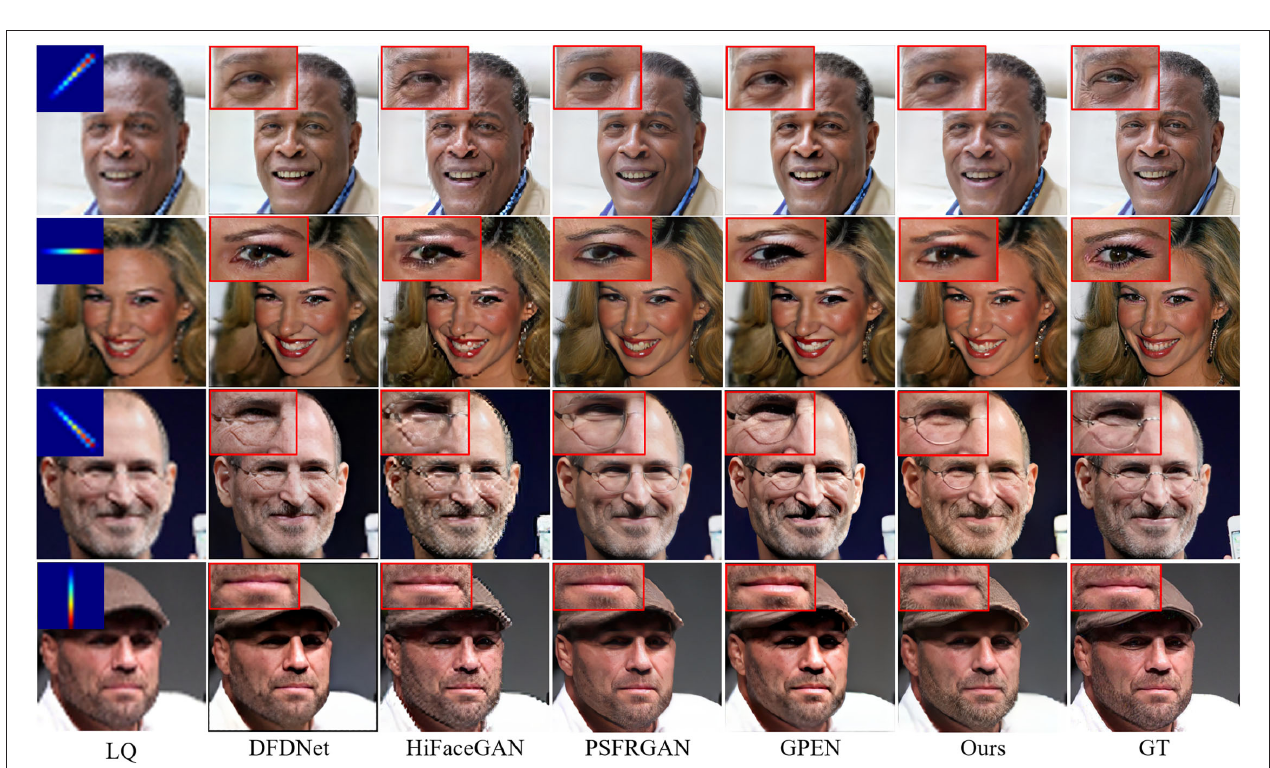
FIGURE 11 | Visual comparison achieved on noise-free degradations with different blur kernels. The blur kernels are illustrated with green boxes.